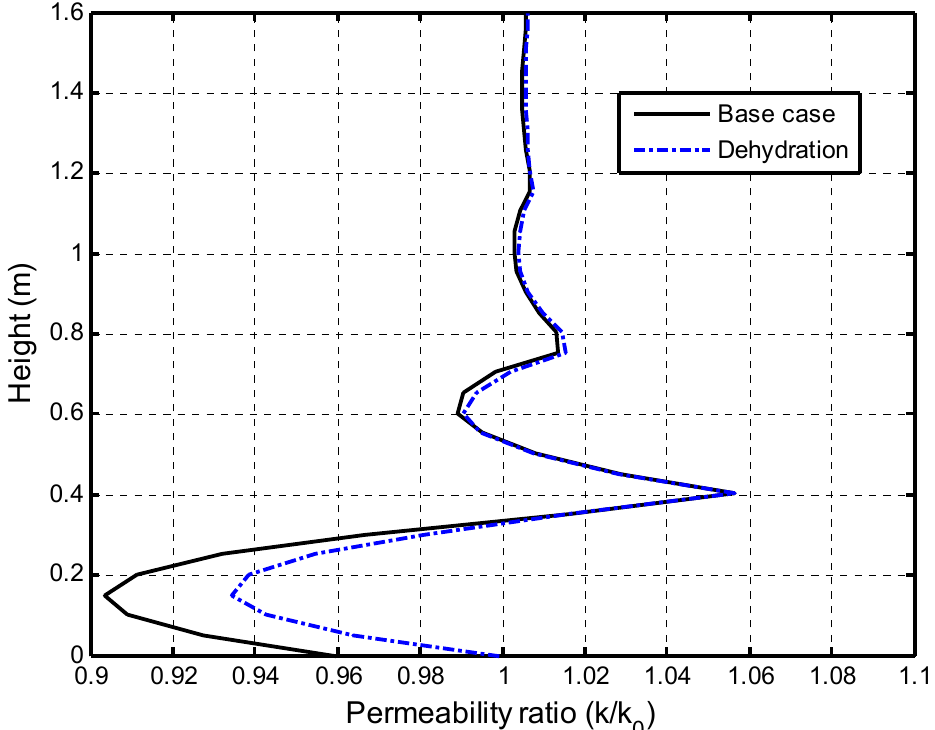
Figure 12. Comparations of permeability distribution in the vertical direction at 3.17 years.